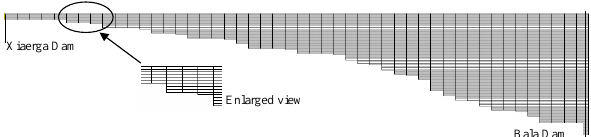
Fig. 2. Grid structure of Bala